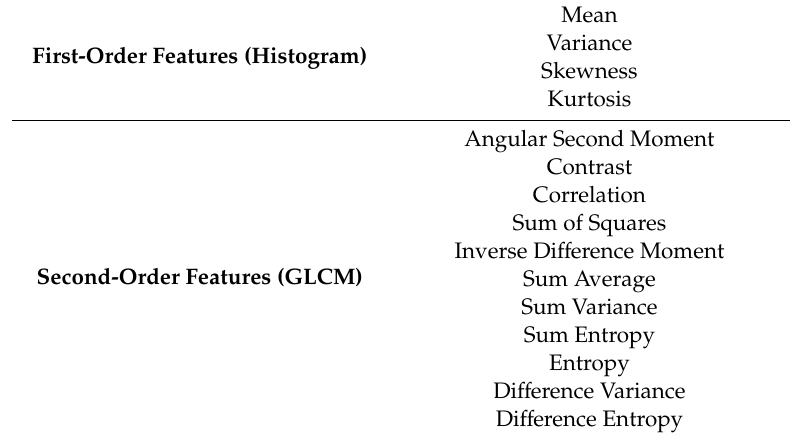
Table 1. Features considered in this study. See [22] and Supplementary Materials for